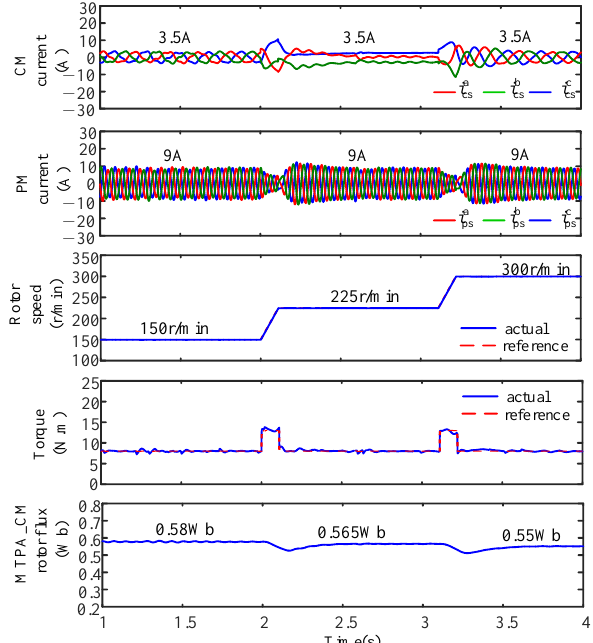
Figure 11. When the speed varies, the simulation experiment verifies the MTPA-(SFV-FLC)’s ro-